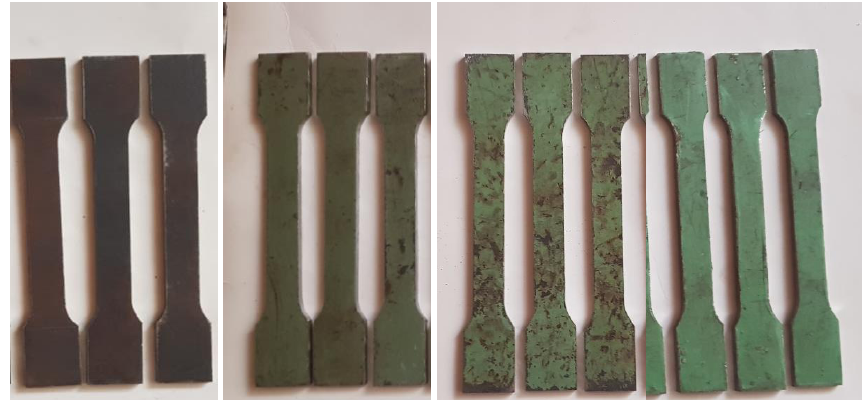
Figure 4 : Tensile test samples (base metal)